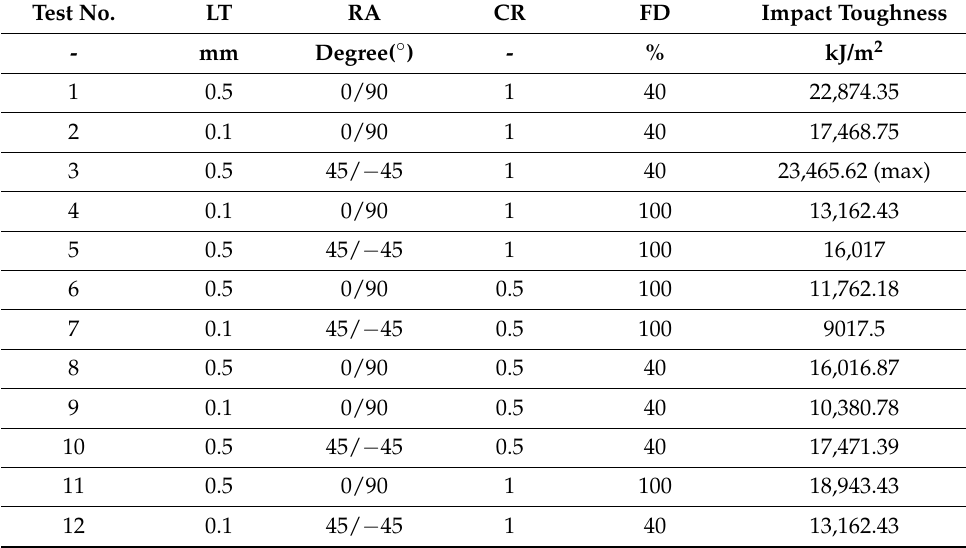
Table 3. Experimental plan and Impact Toughness Results of hybrid laminar composite. Test No. Test